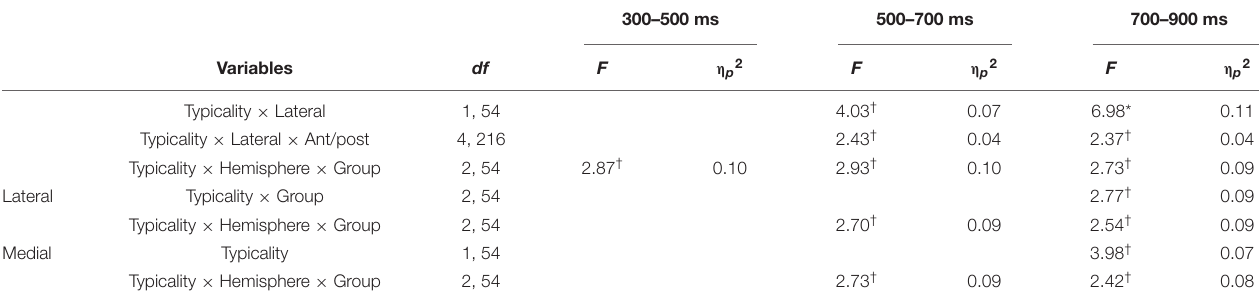
TABLE 4 | F -values for omnibus and follow-up analyses of ERP effects to Swedish placement